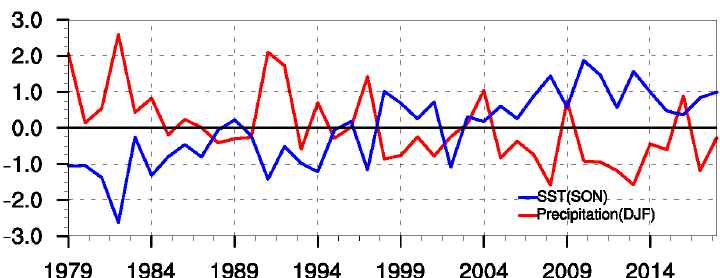
Figure 2. The time series of winter NAM precipitation index (NAMPI) ( red line ) and autumn SPOD index (SPODI) ( blue line ).